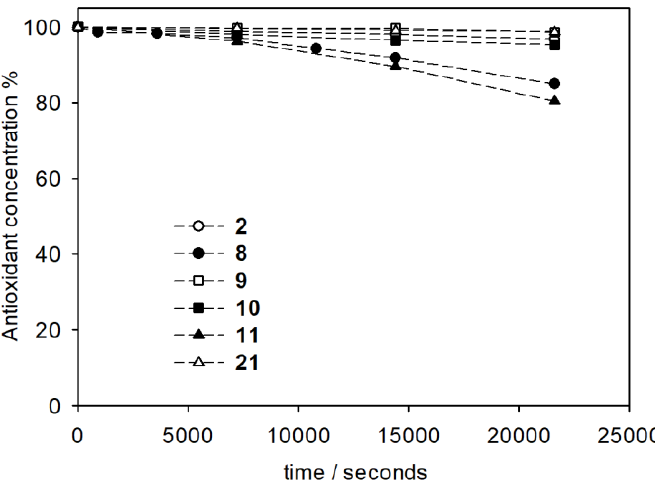
Figure 4. Stability at 130 °C of selected phenols in triacetin under air. Error bars are smaller than the symbol size.